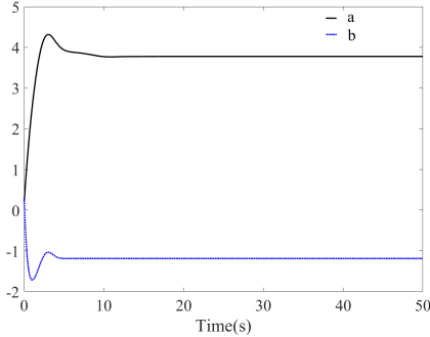
ˆ b (with disturbance,